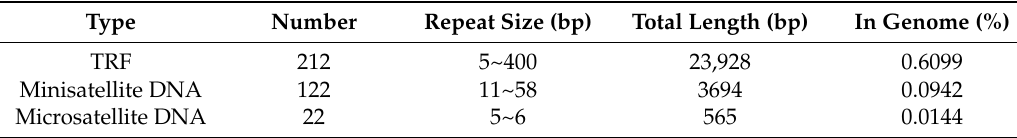
Table 3. Information of tandem repetitive sequences.